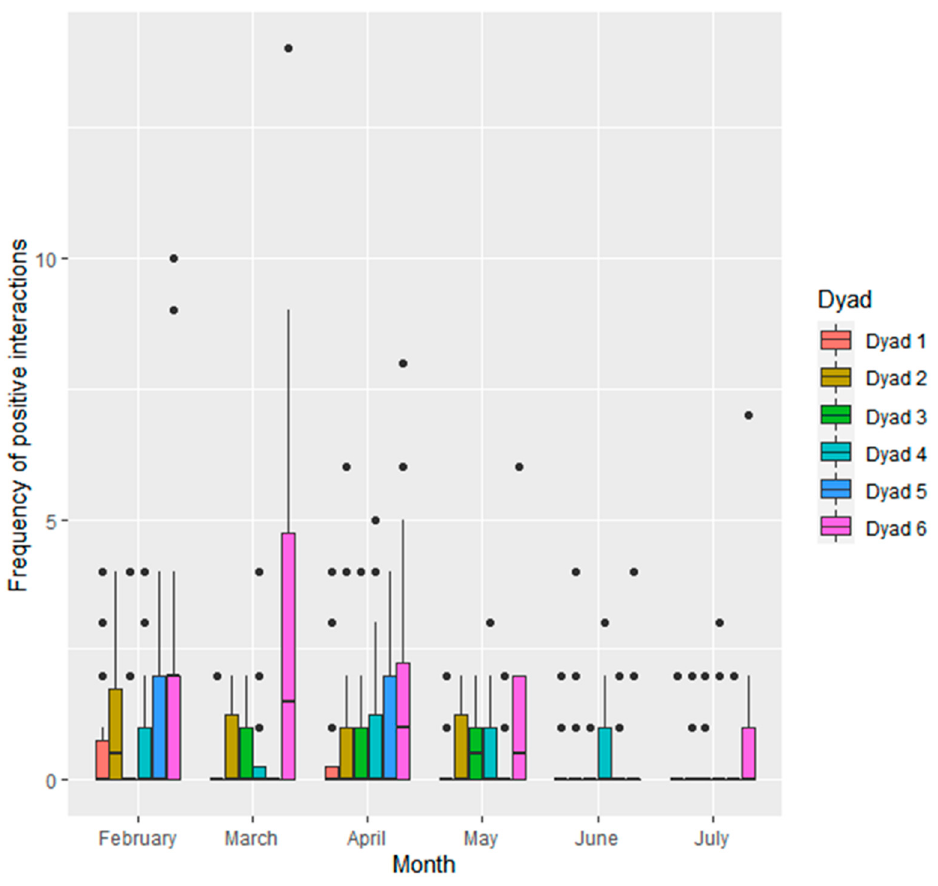
Figure 4. Frequency of positive social interactions given within each seal dyad ( n = 6; dyad 1: S1 and S2, dyad 2: S1 and S3, dyad 3: S1 and S4, dyad 4: S2 and S3, dyad 5: S2 and S4, dyad 6: S3 and S4) per observation period. Table 3. Average percentage of each observation period that seals were observed with